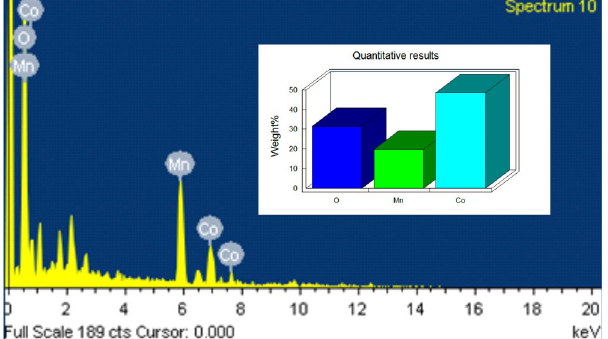
Figure 5. EDX spectrum and element weight % bar diagram of MnCo 2 O 4 .